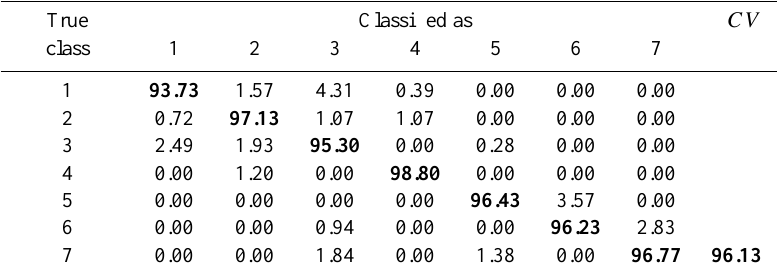
Table 2. Confusion matrix of CV for equally involved features in %. True Classified as CV